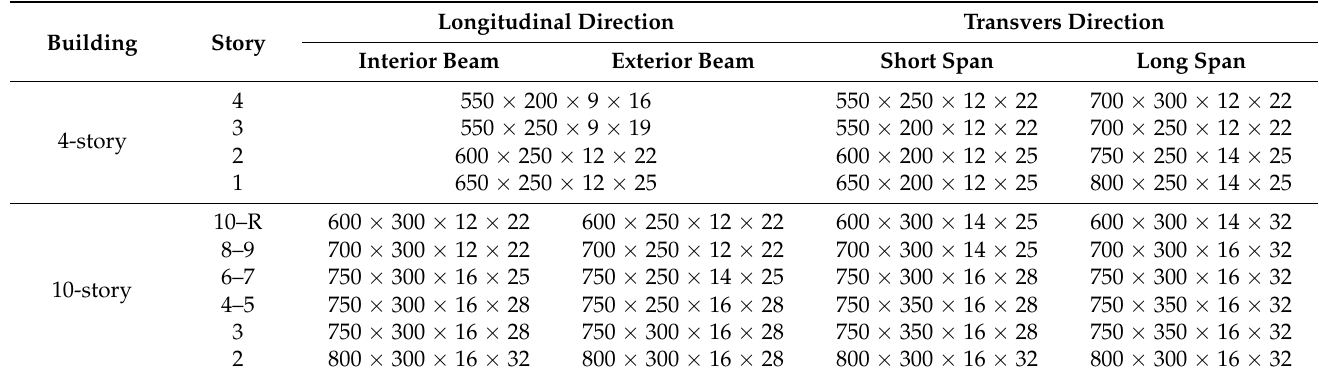
Table 4. Detail and size of structural beams (mm).